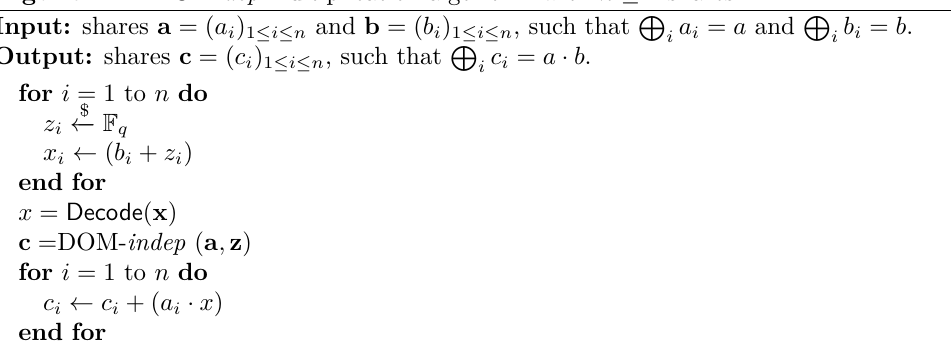
Algorithm 2 DOM- dep multiplication algorithm with n ≥ 2